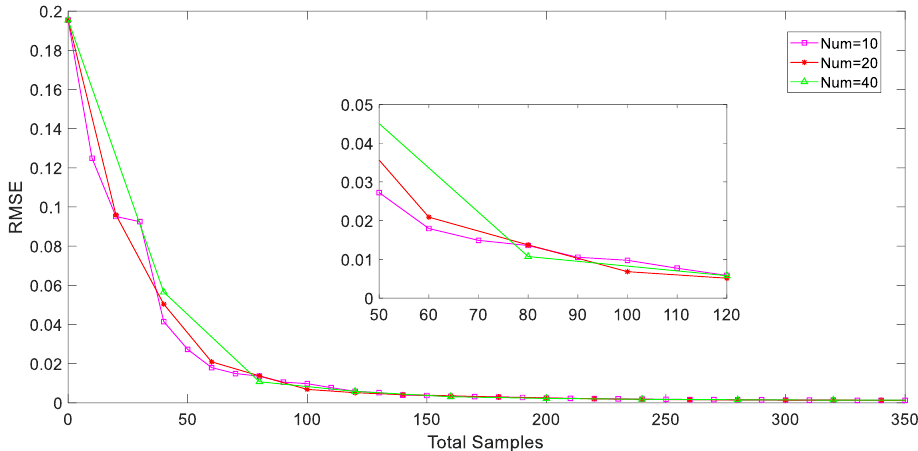
Figure 9. RMSE values of penicillin concentration for the AL based soft sensors under different total numbers of labeled samples.